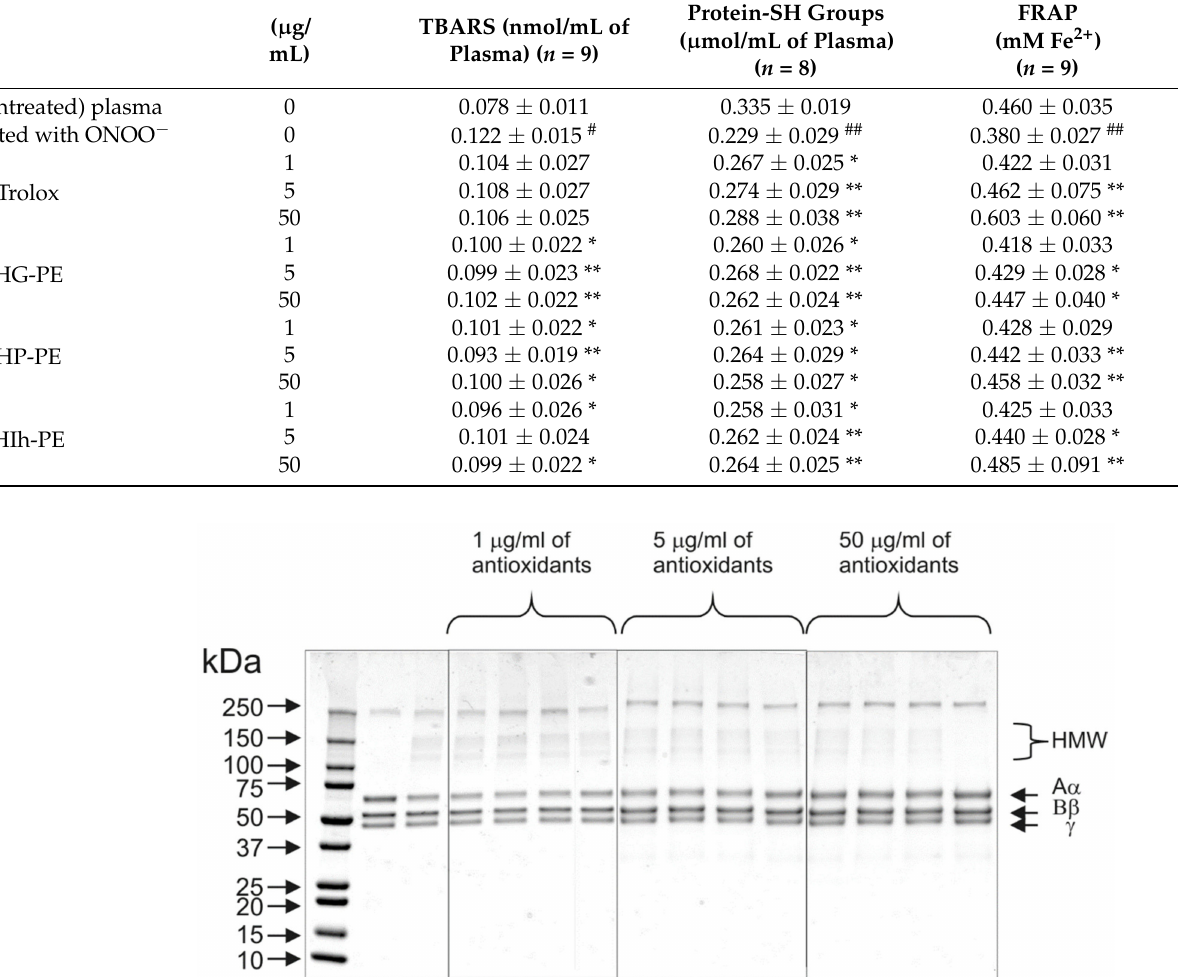
Table 2. Determination of antioxidant properties of the examined Herniaria glabra (HG-PE), H. polygama (HP-PE), and H. incana herb (HIh-PE) purified extracts, based on measurements of thiobarbituric acid-reactive substances (TBARS) and protein thiol groups levels as well as on the ferric reducing ability of blood plasma (FRAP), under the ONOO − -induced oxidative stress In Vitro. Statistical significance: # p < 0.05, ## p < 0.001 plasma treated with ONOO − in the absence of ex- amined purified extracts vs. control plasma; * p < 0.05, ** p < 0.01 plasma treated with ONOO − in the absence of examined purified extracts vs. plasma treated with ONOO − in the presence of examined substances.